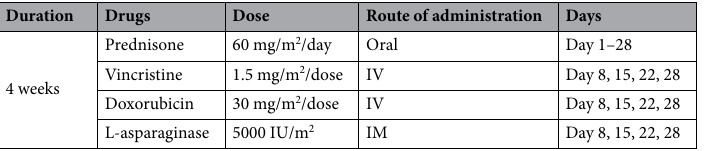
Table 1. Modified Berlin-Frankfurt-Munster 95 dose schedule in Phase A induction